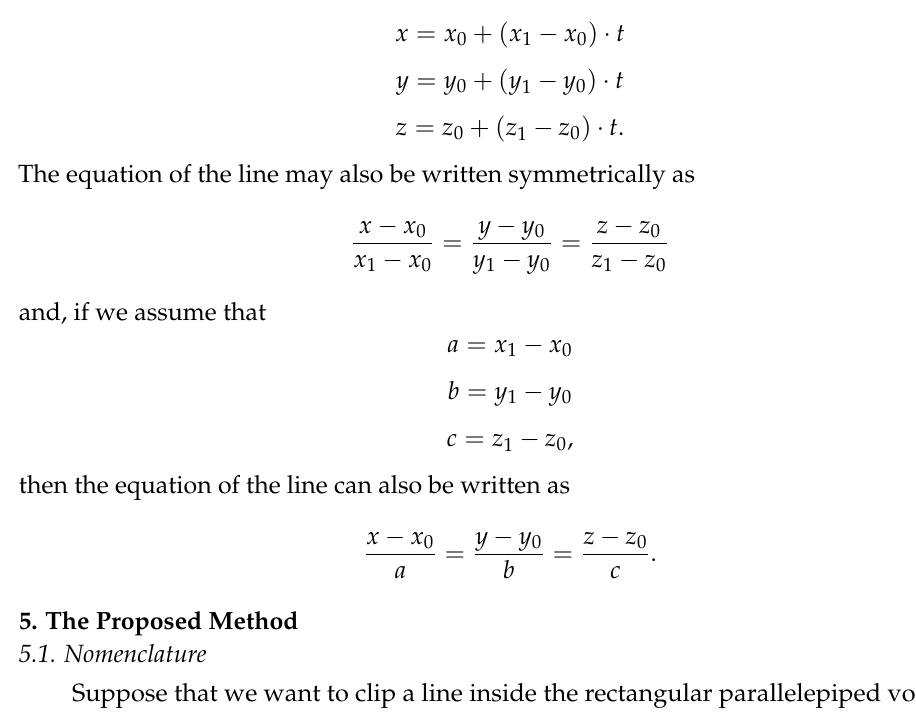
Figure 13. The dimensions of the volume range from x min to x max for the X axis